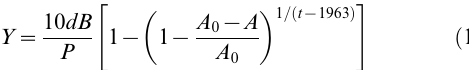
Gentle slope landscape